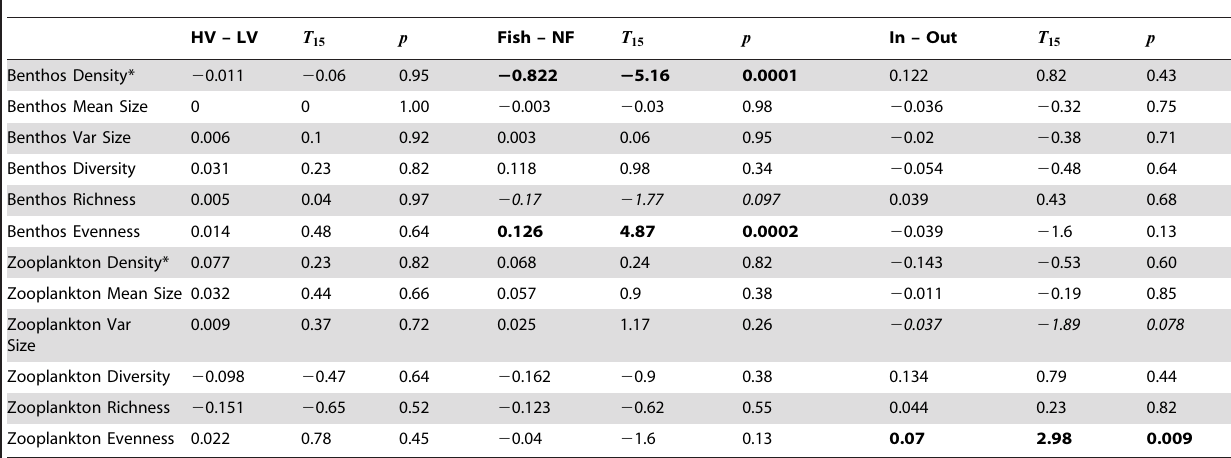
Table 1. Treatment effects on food web variables.